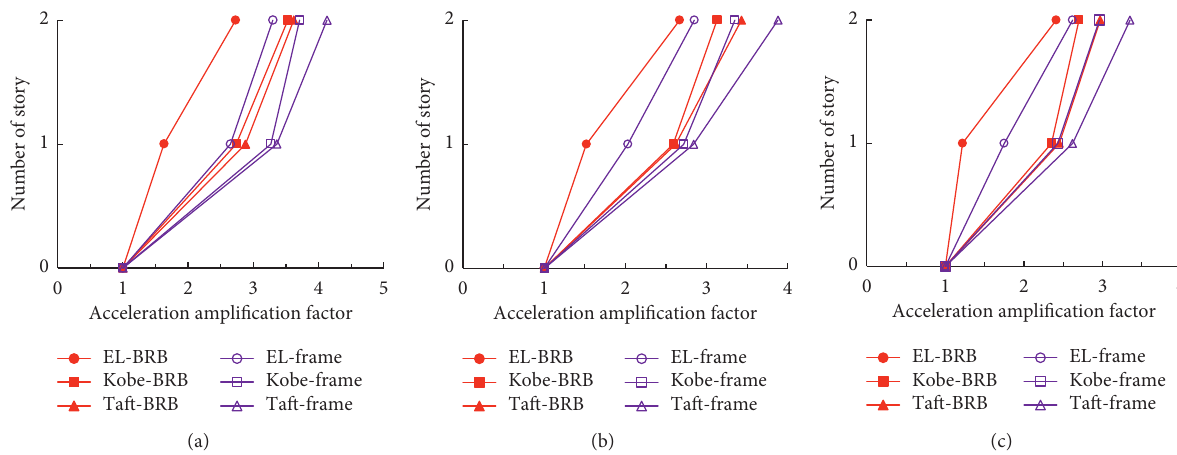
Figure 15: Acceleration amplification factor of the specimen. (a) Frequent earthquake. (b) Occasional earthquake. (c) Rare earthquake.